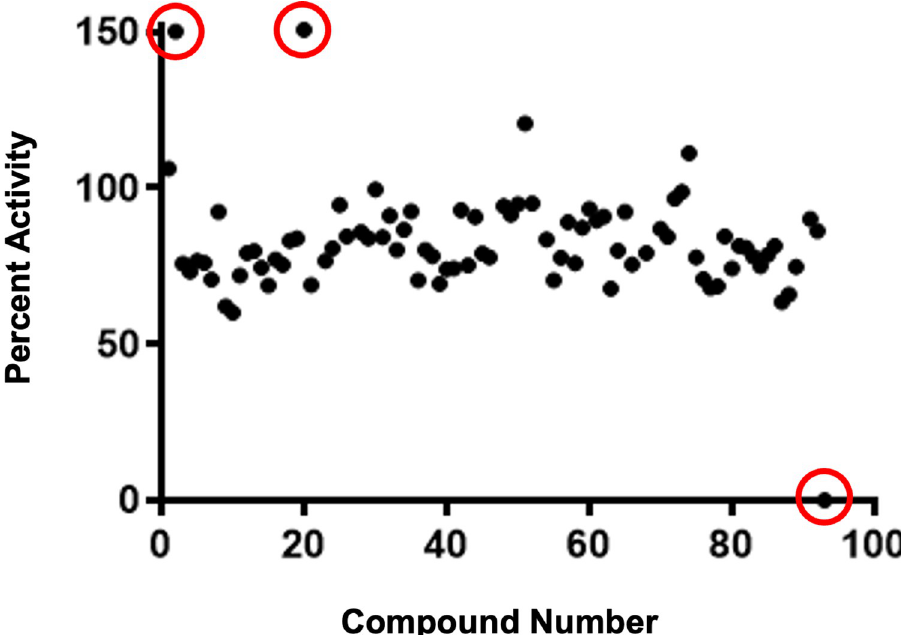
Fig 3. NAMPT activity assay biochemical screen of Autodock Vina ranked carbon skeletons. Unique, high binding molecules within the NCI Diversity Set III library screen were tested for modulation of NAMPT activity. Candidates were diluted to 20uM final concentration and evaluated a minimum of 2 independent trials. Molecules that consistently produced greater NMN product are circled (left of panel). Known inhibitor FK866 was included as a negative control, circle to bottom